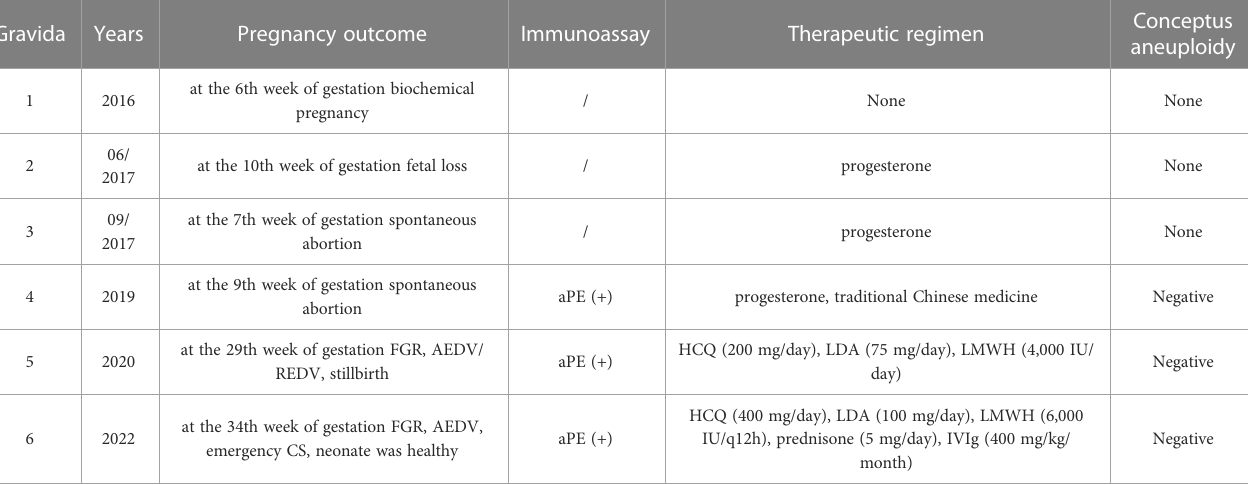
TABLE 3 Pregnancy history of case